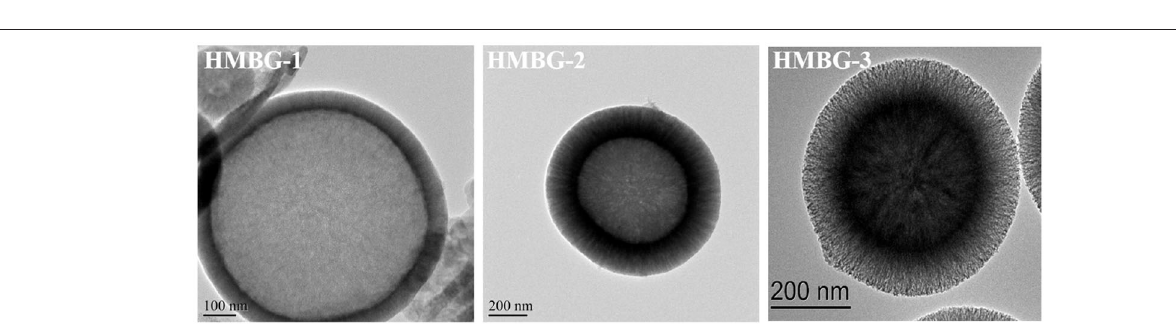
FIGURE 3 | The drug release behavior of IBU-HMBG nanoparticles (A) and the magnifying image between 60h and 180h (B) .